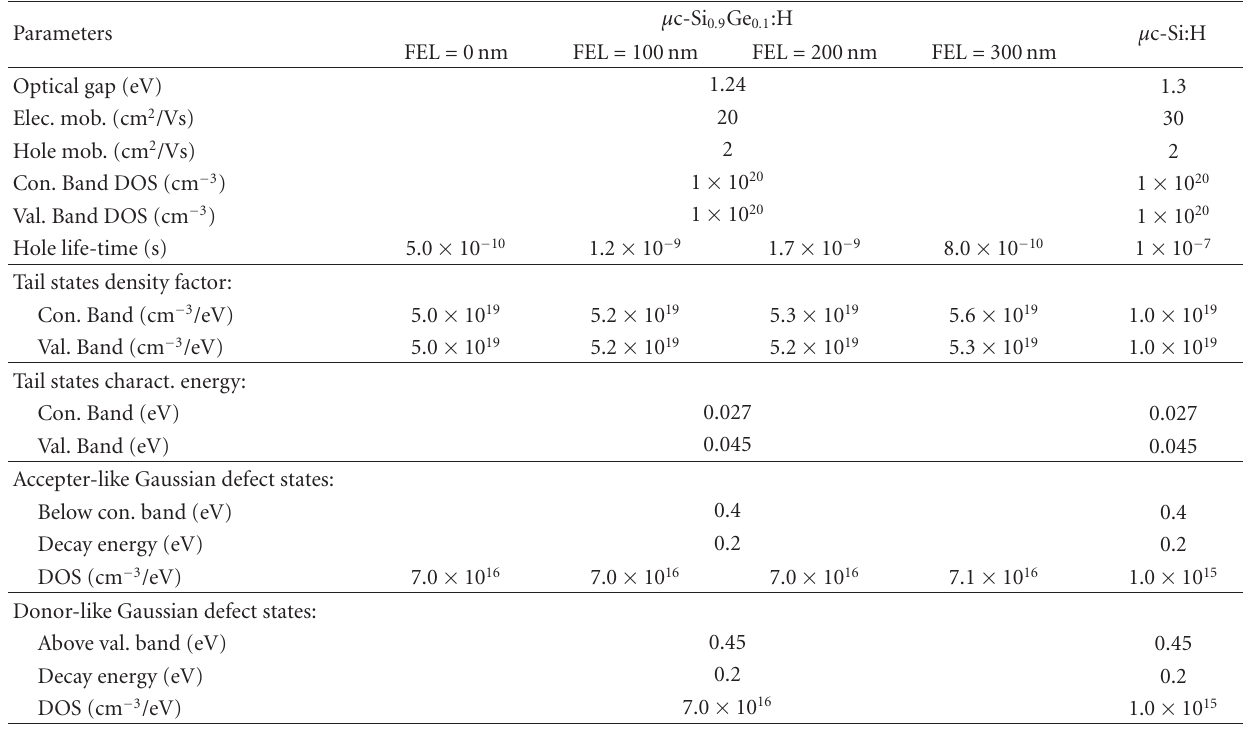
Table 1: Material parameters.